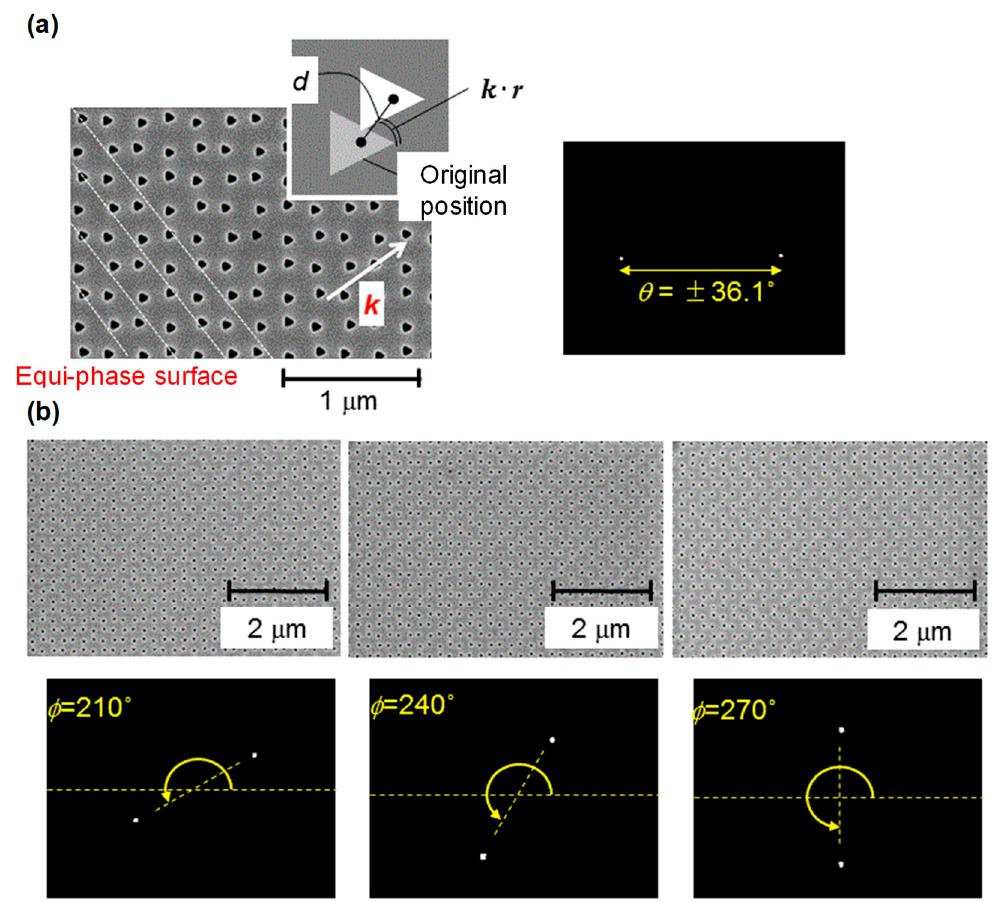
Figure 9. Demonstration of the control of output direction by modulated photonic crystals. ( a ) SEM image of a photonic crystal designed for an output angle θ of 36.2° and the measured far-field pattern (FFP). ( b ) Control of azimuth angles φ . © 2017 IEEE. Reprinted, with permission, from [15].